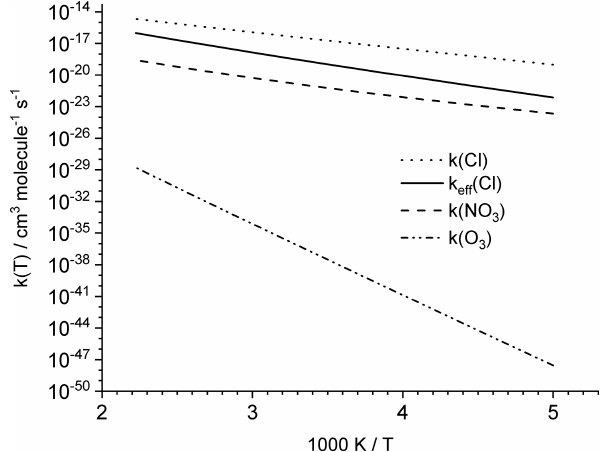
Figure 2. Predicted rate coefficient k(T ) for the reaction of HNCO + OH compared against experimental data. The shaded area indicates the experimental uncertainty reported by Wooldridge et al. (1996). The dashed line estimates the 298K rate coefficient that would be needed to remove 10% of the atmospheric HNCO by re- action with OH (see text).